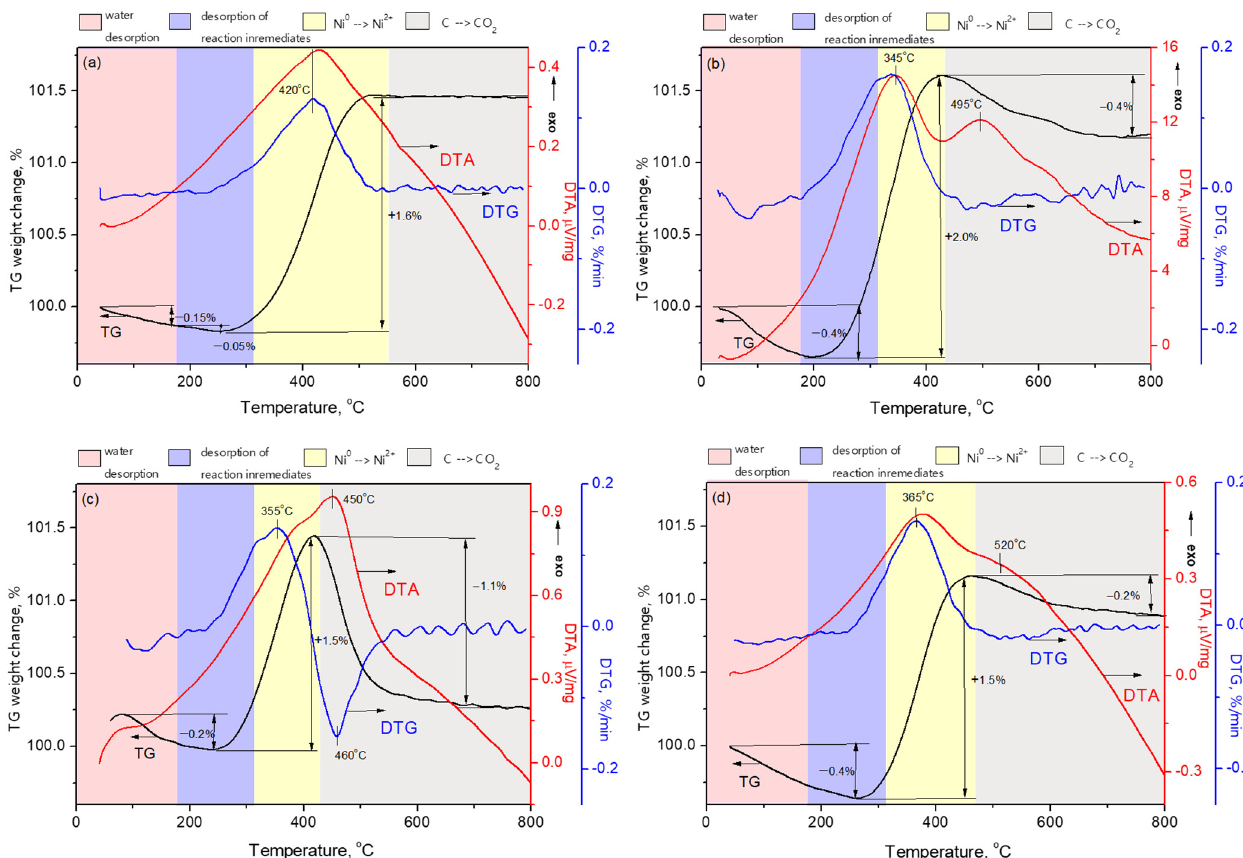
Figure 22. Thermal analysis of the spent Ce 0.8 Ni 0.2 O 1.8 ( a ) and (CeM) 0.8 Ni 0.2 O y [M = Al ( b ), La ( c ), Mg ( d )] sample in an air flow. ( b – d )—M/Ce molar ratio is equal to 0.3. Reaction conditions: 800 °C, 24 h.